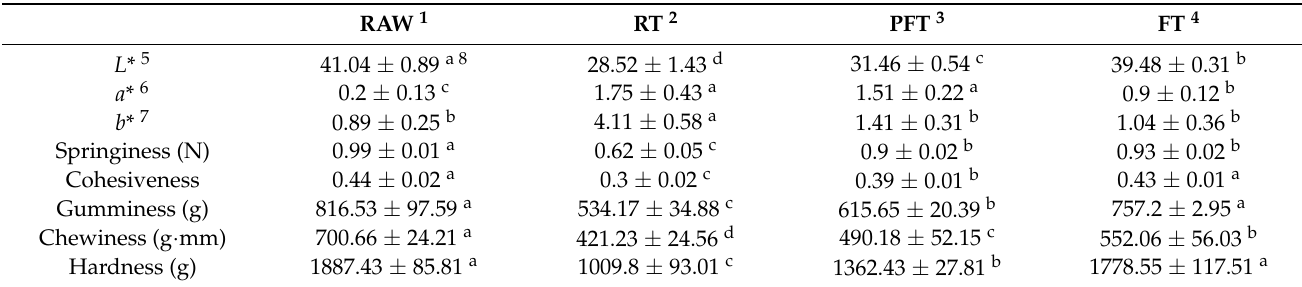
Table 1. Physical quality analysis of L. vannamei after low-temperatures storage.